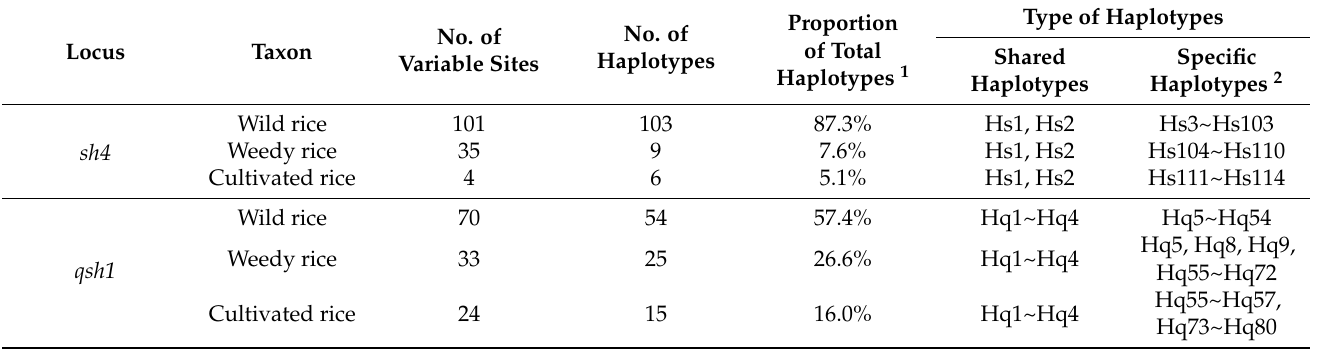
Table 1. The number of identified variable sites and haplotypes in the analyzed DNA sequences of the sh4 and qsh1 seed-shattering loci in wild, weedy, and cultivated rice samples.